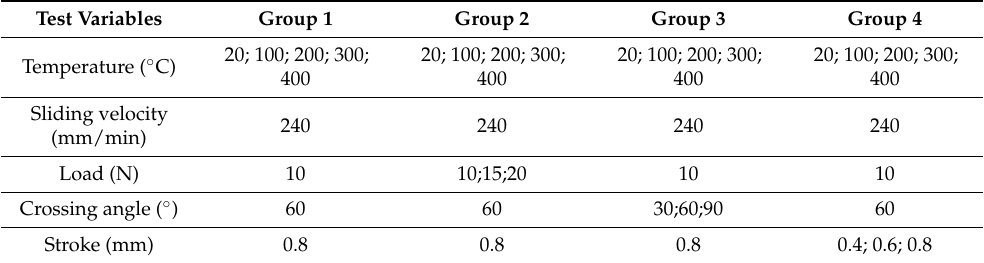
Table 2. Experimental parameters used in different